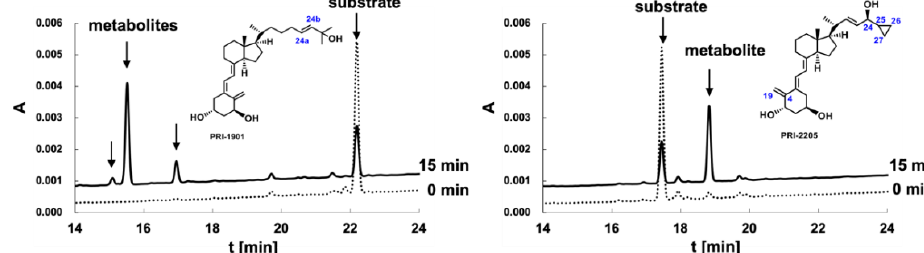
Figure 8. HPLC profiles of 1,25D3 analogs (PRI-1901 and PRI-2205) and their metabolites, before and after incubation with h CYP24A1. UV absorbance was recorded at 254 nm. The upper chromatograms represent profiles of the reaction mixture following incubation with h CYP24A1 for 15 min. The lower chromatograms were obtained at the starting point.